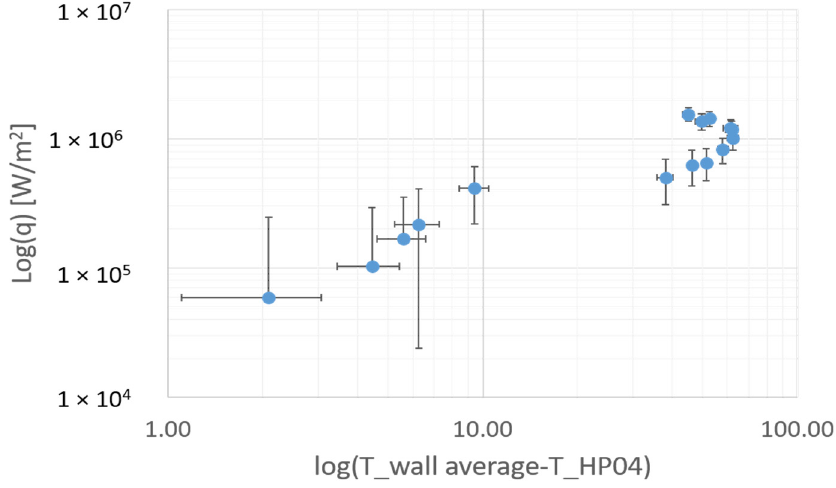
Figure 21. Heat flux versus average wall superheated Δ T of mock-up 1 heated via electric heater